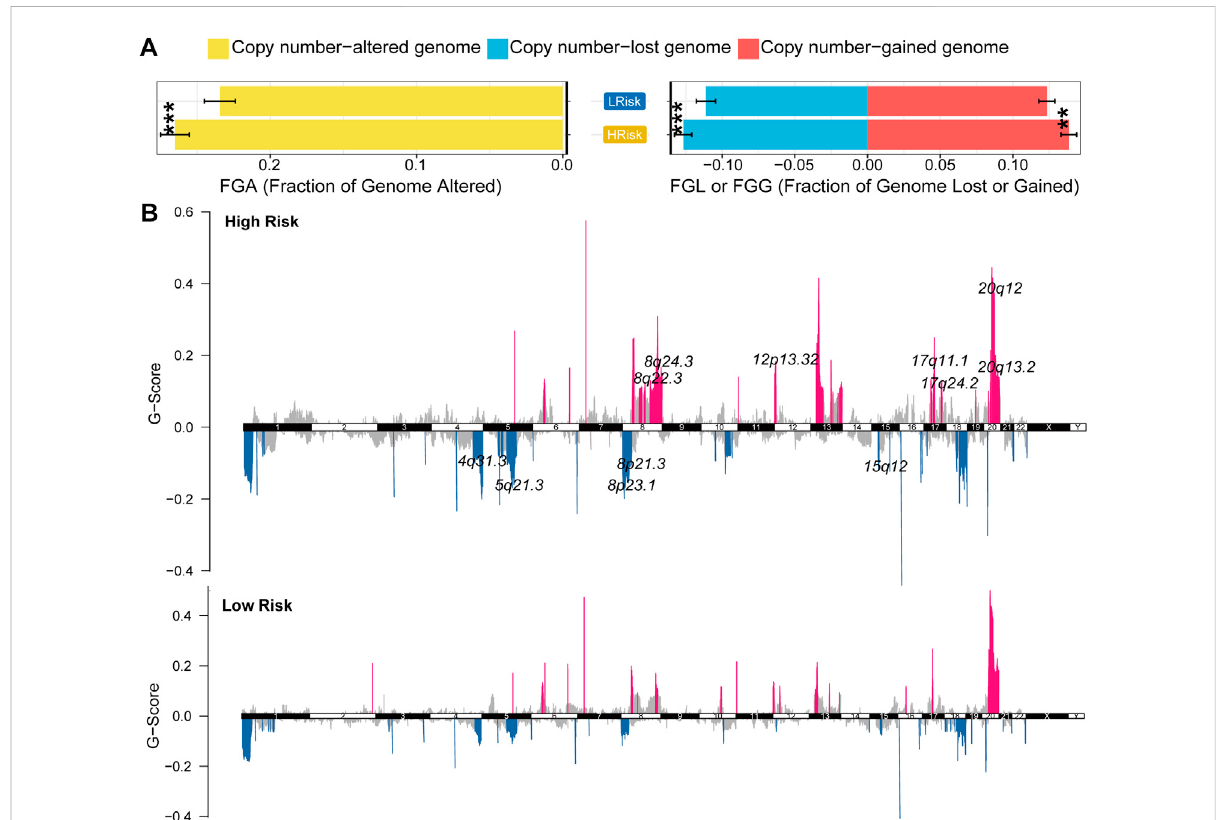
FIGURE 6 Characterization of copy number variation in the entire TCGA cohort (A) The difference in genomic alterations between the two groups. The p values were calculated by Wilcoxon test (* p < 0.05; ** p < 0.01; *** p < 0.001; **** p < 0.0,001) (B) GISTIC cytoband of copy number alteration for all